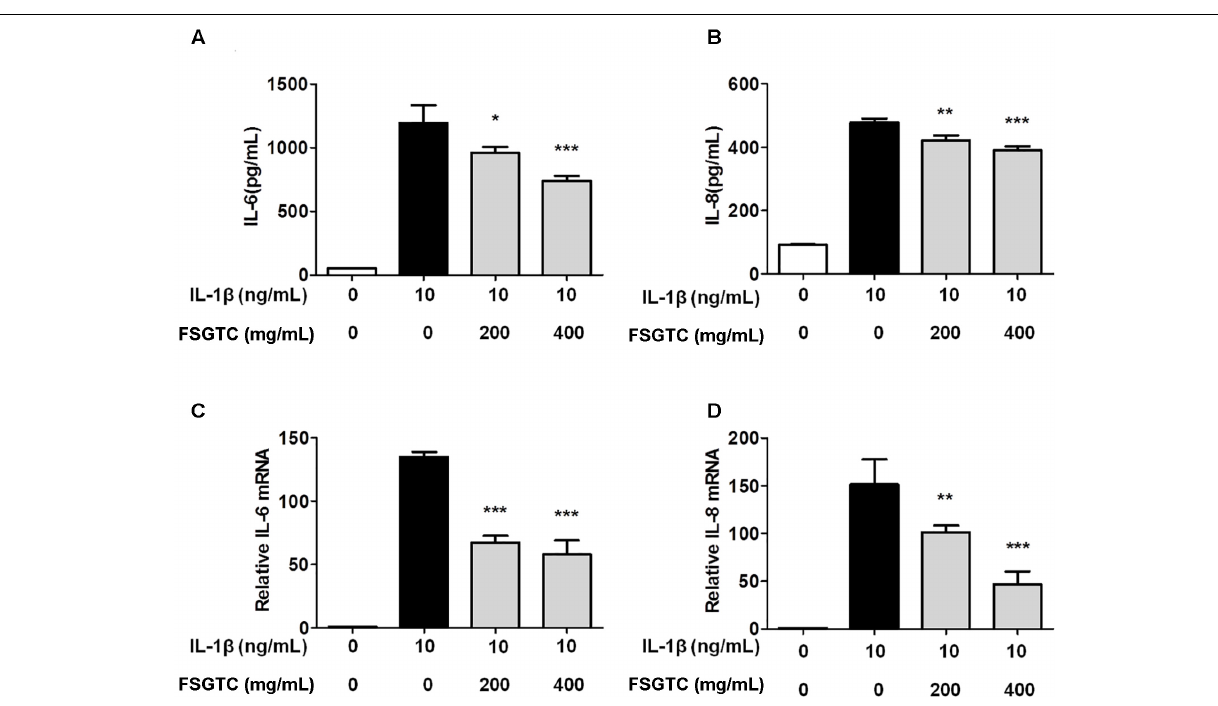
FIGURE 4 | Effects of FSGTC on IL-1 β -induced protein levels of IL-6 (A) and IL-8 (B) as well as mRNA expression of IL-6 (C) and IL-8 (D) in SW982 cells. The cells were treated with various doses (200 and 400 mg/mL) of FSGTC. The supernatants were collected and analyzed for IL-6 and IL-8 by ELISA kits. The total RNA was collected and prepared for qPCR of IL-6 (C) and IL-8 (D) from SW982 cells. GAPDH was used as an internal control to normalize the data. Data are presented as the mean ± SD. Statistical analyses were performed by one-way ANOVA test, followed by Dunnett’s post hoc test. n = 3, x ± s . ∗ p < 0.05; ∗∗ p < 0.01, ∗∗∗ p < 0.001 vs. IL-1 β without